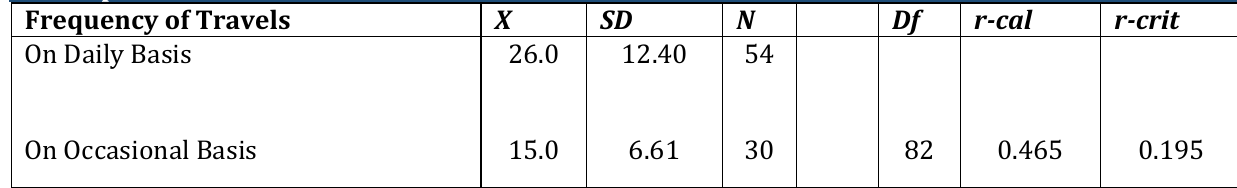
Tab. 9: Correlation between Frequency of Travel and Distance Covered by Commuters in Lagos Metropolis Frequency of Travels On Daily